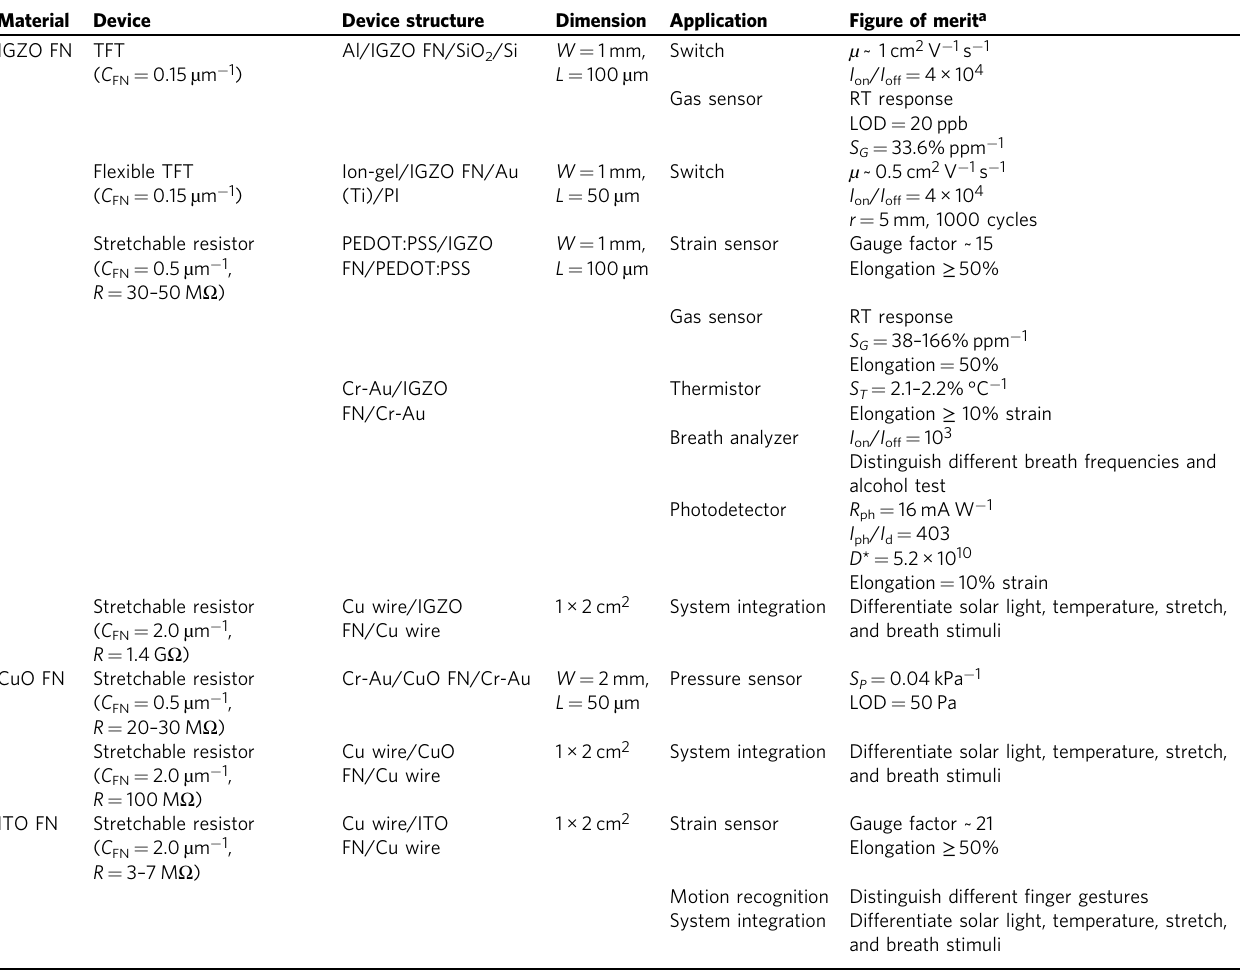
Fig. 1 Synthesis and structural characterization of the present metal and metal oxide fi bers. a Schematic of the blow-spinning method. b Photograph of a metal salt/PVB fi ber mat of IGZO fi bers. Scale bar = 1 cm. c Optical image PVB fi bers without metal salts. Scale bar = 50 μ m. d SEM image of PVB fi bers without metal salts. Scale bar = 10 μ m. TEM images and SAED patterns of thermally processed e IGZO, f ITO, g CuO, and h Cu fi bers. Scale bar = 200 nm. Insets are selected area electron diffraction patterns. Scale bar = 5 1/nm. SEM images of i IGZO and j ITO fi bers in curved states with a radius of ~2.5 µ m. Scale bar = 10 μ m. Table 1 Structure, function, and representative device fi gure of merit reported in this study. Material Device Device structure Dimension Application Figure of merit